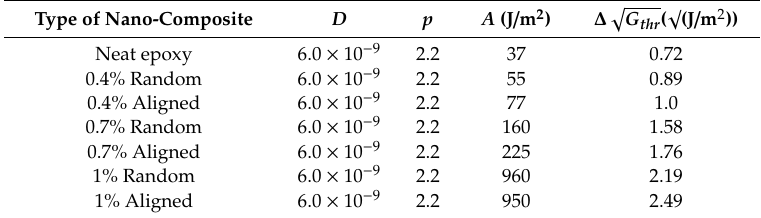
Figure 10. Comparison of the measured [79] and computed da / dN versus ∆ nano-composite adhesives. Table 6. Values of the constants used to represent the da / dN versus ∆